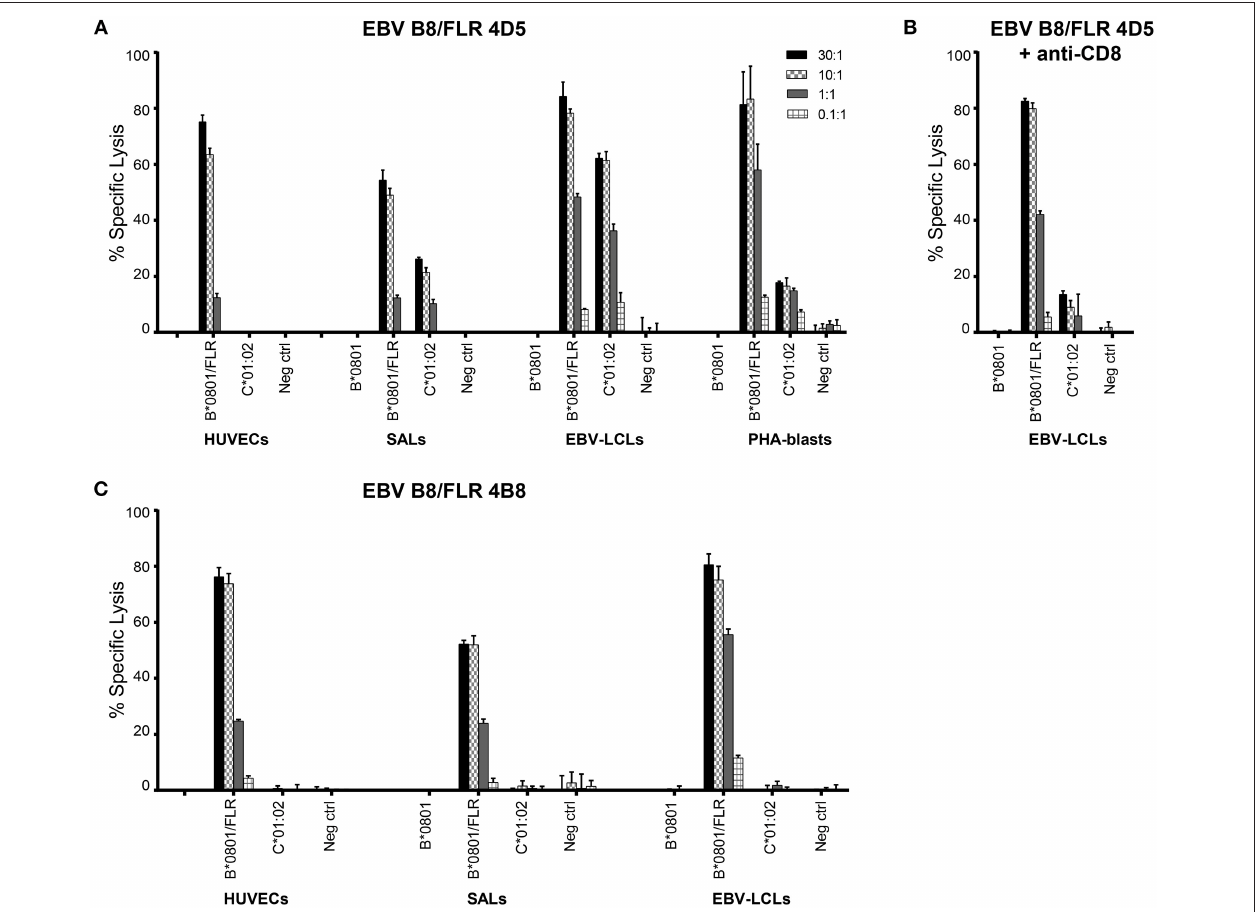
FIGURE 2 | EBV B8/FLR T cell clone 4D5 is cytotoxic against HLA-C*01:02. Cytotoxicity of T cell clones 4D5 (A) and 4B8 (C) was tested against 51 Cr-labeled HUVECs, SALs, EBV-LCLs, and PHA blasts expressing the recognized allo-HLA-C*01:02 allele and the virus-specific restriction HLA allele loaded with viral peptide as a positive control. As a negative control, target cells expressing no HLA-B*0801 and HLA-C*0102 were included. (B) T cell clone 4D5 was incubated with an anti-CD8 blocking antibody prior to co-culture with 51 Cr-labeled EBV-LCLs and specific lysis was measured. Bars represent triplicate values with standard deviation of the